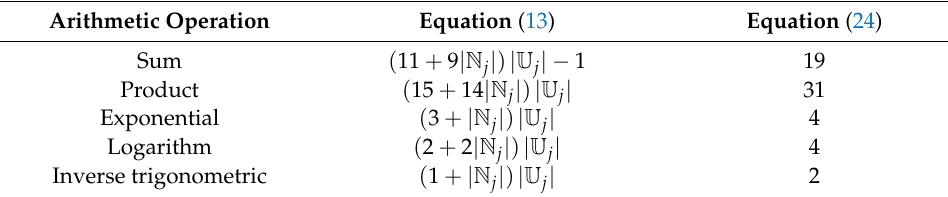
Figure 5. The convergence of R j with respect to η for both square and hexagonal cells (zones). Table 2. Comparison of numbers of arithmetic